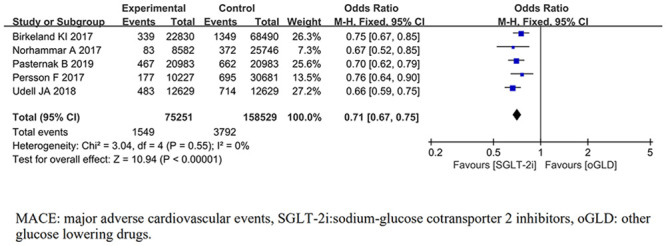
Forest plot of MACE for SGLT-2i and oGLD.